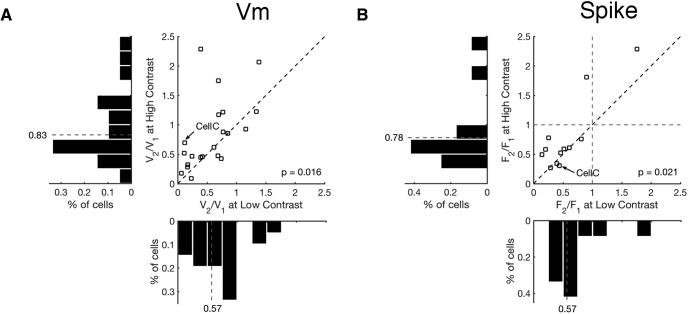
Population results of mouse V1 cells recorded with contrast-reversing gratings. A, B, Scatter plots of membrane potential modulation ratios (V2/V1) (A) and spiking modulation ratios (F2/F1) (B) at low (22% or 32%) and high (100%) contrasts. The diagonal broken lines indicate the unity lines, where the modulation ratio is the same at high and low contrasts. In B, the horizontal and vertical broken lines indicate F2/F1 = 1. Compared to high contrasts, the modulation ratios showed significant increases at low contrasts in both membrane potential responses (n = 21, one-sided t-test, p = 0.016) and spiking rate (n = 12; one-sided t-test, p = 0.021). Data from the example cell in Figure 7 is marked as Cell C on both A and B. Histograms of distributions of modulation ratios at high and low contrasts are plotted on the same scale next to the corresponding scatter plot axis. The broken lines indicate the means of the distributions.